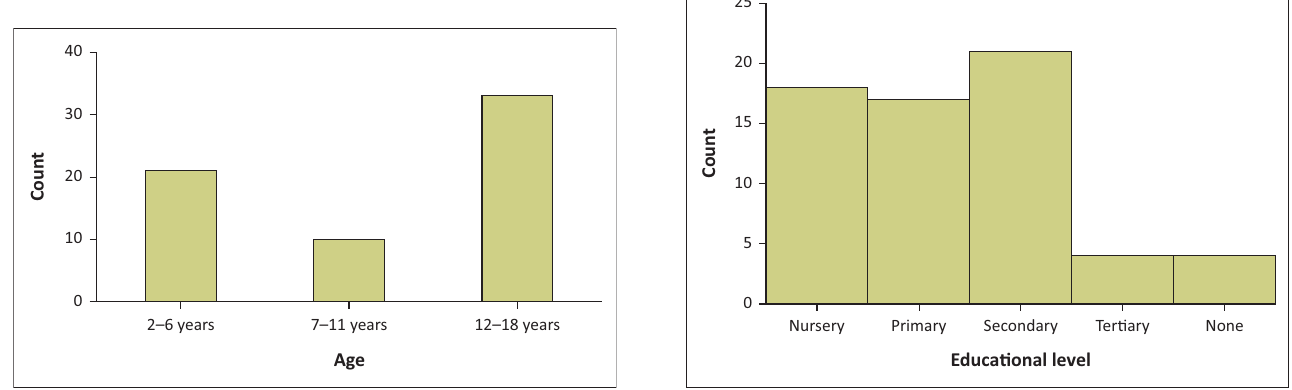
FIGURE 3: Distribution of respondents’ responses on educational